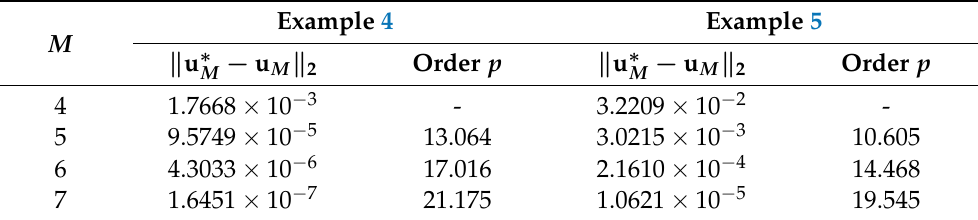
Table 9. Convergence orders of the approximate solutions for Examples 4 and